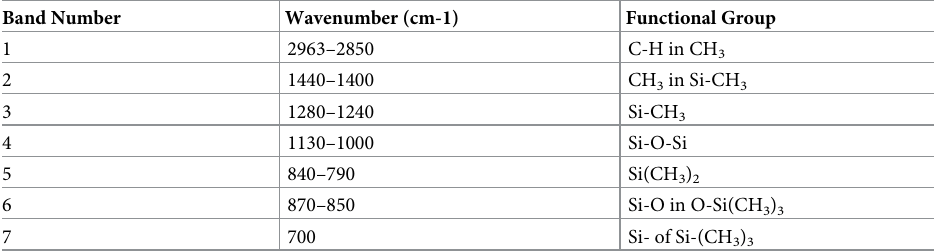
Table 3. Informations about wavelength and the basic functional